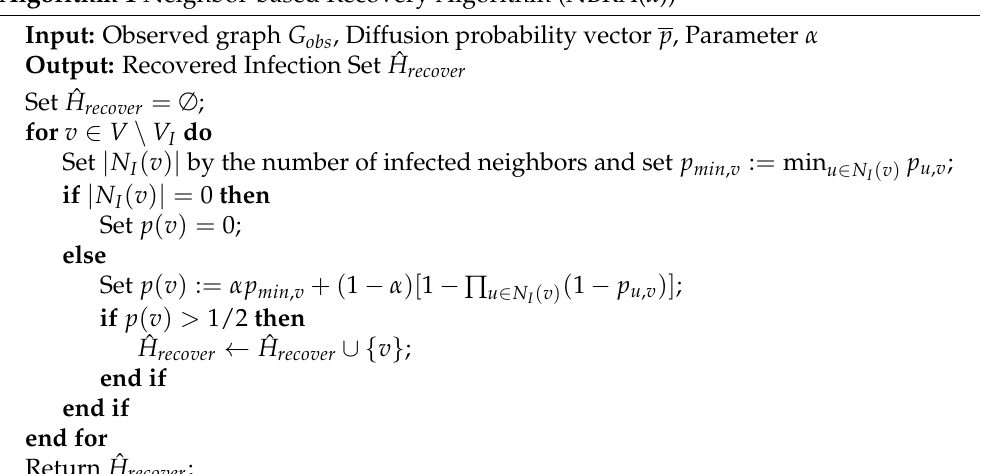
Algorithm 1 Neighbor-based Recovery Algorithm (NBRA( α